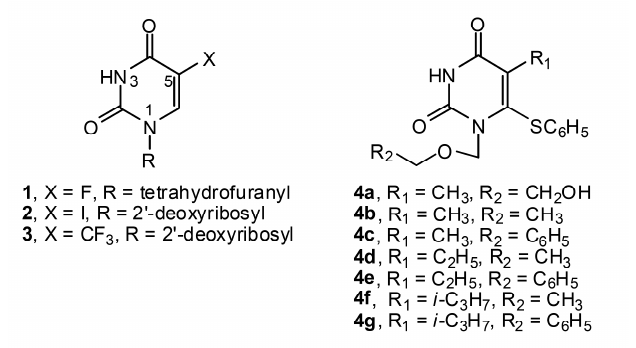
Figure 1. Structures of substituted uracil analogs 1 - 4.